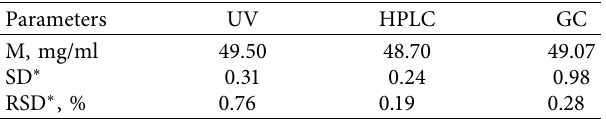
Table 5: Test results of the repeatability study of BAC quantitative determination in the “VIROSAN F”.